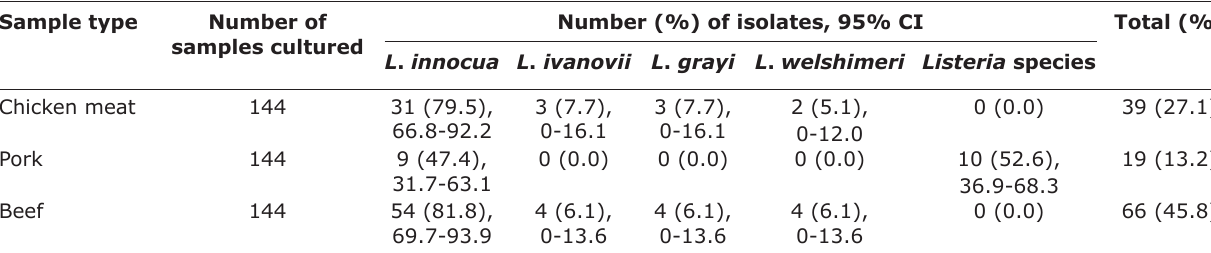
Table-1: Distribution of Listeria species in raw meats in Enugu State Southeast Nigeria. Sample type